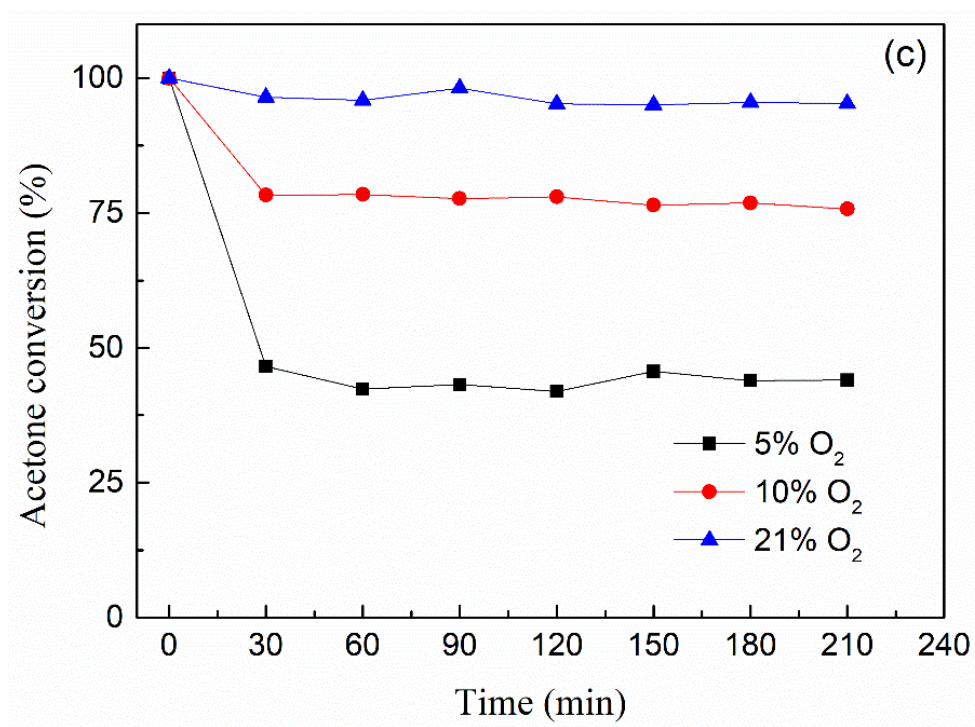
Figure 6. The acetone conversion of the catalysts for acetone ( a ); effects of reaction temperature on the removal efficiency of acetone over Ce 0.8 -Mn/AC as a function of time (reaction conditions: acetone concentration = 238 mg/m 3 , oxygen content = 21%) ( b ); effects of oxygen content on the removal efficiency of acetone over Ce 0.8 -Mn/AC as a function of time (reaction conditions: acetone concentration = 238 mg/m 3 , reaction temperature = 250 ◦ C) ( c ).